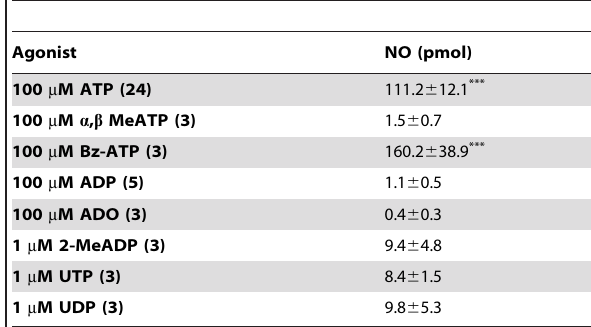
Table 1. NO production in hippocampal slices induced by purinergic